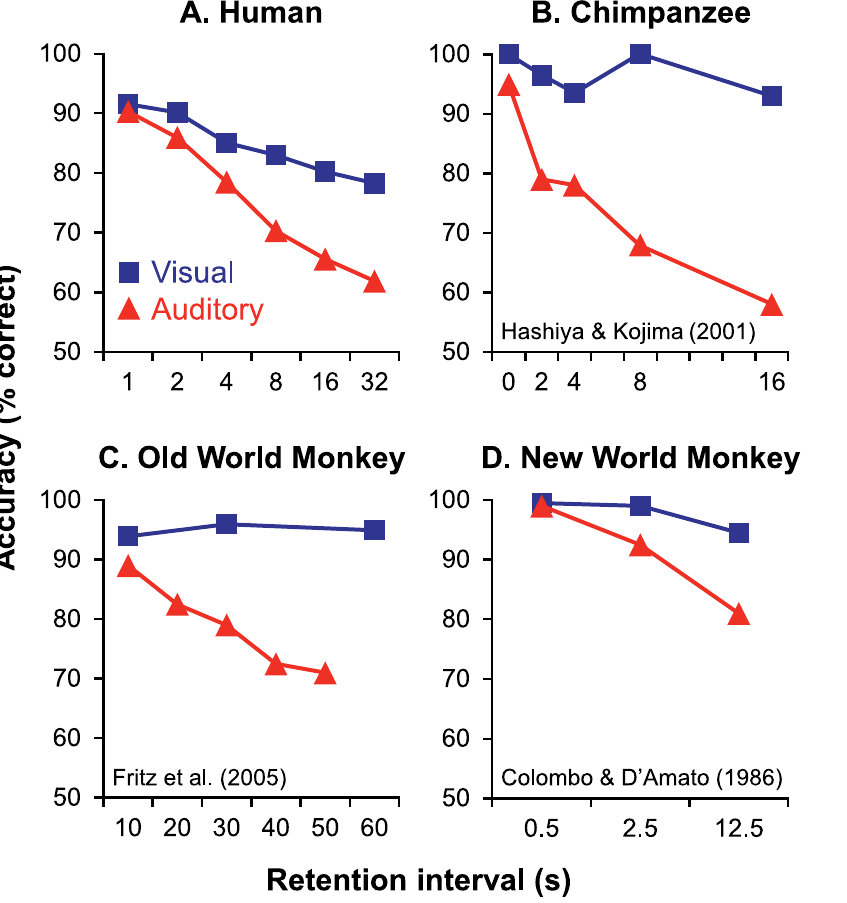
Figure 3. Comparison of visual and auditory short-term memory among primates. (A) In the present experiment, inferior retention was observed for auditory compared to visual stimuli in human subjects. This pattern of results is qualitatively similar to that which has been observed in the chimpanzee (B), as well as both old-world (C) and new-world monkeys (D). (B) Adapted from Hashiya and Kojima [12]; (C) adapted from Fritz et al. [6]; (D) adapted from Colombo and D’Amato [1].